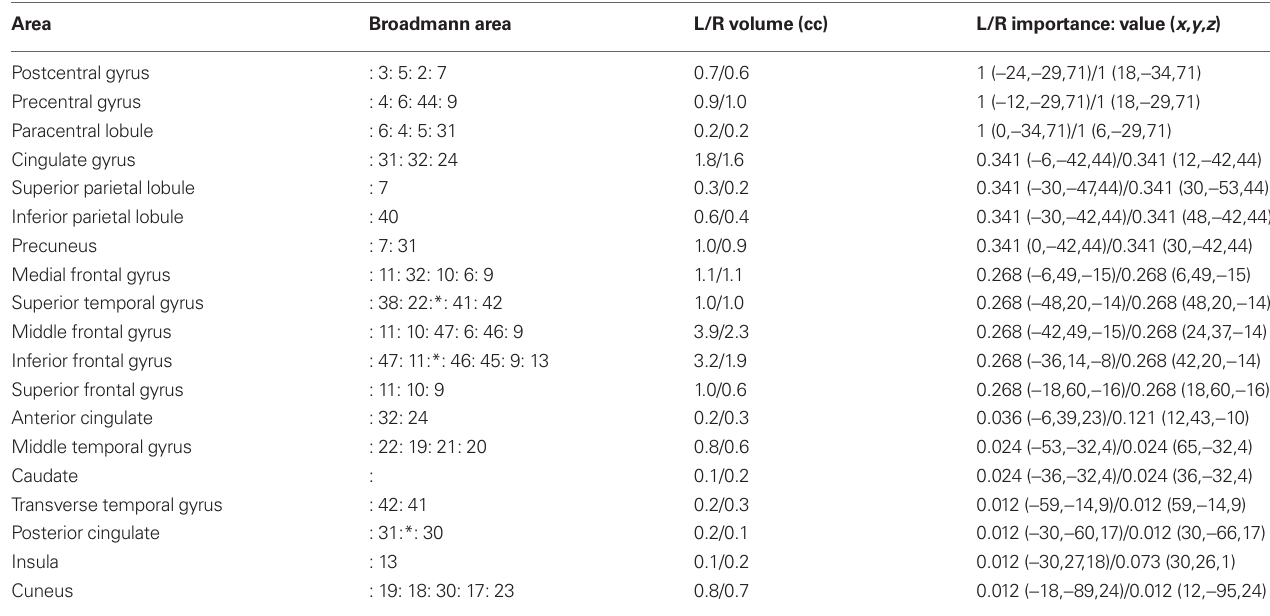
Table 3 | The detail region of selected